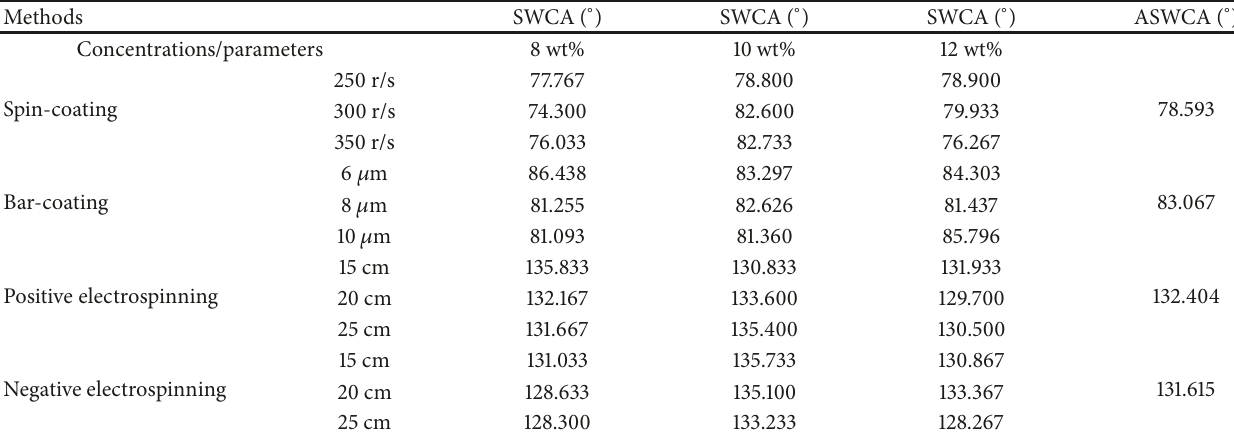
Table 1: The SWCA of the prepared PVB films by different